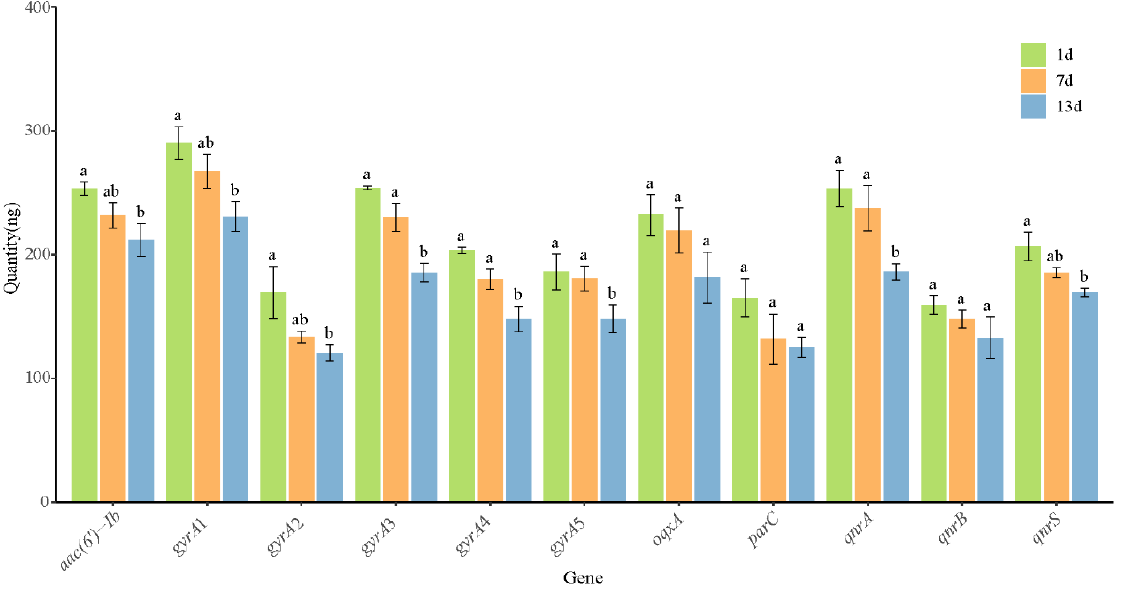
Figure 5. Short-term stability of the quantity of plasmid DNA reference materials stored at 37 ◦ C. For each gene, columns labeled with the same letter indicates that no significant difference was found in plasmid DNA quantity upon storage for different durations. Table 4. Ct values of qPCR for plasmid DNA reference materials stored at 37 °C (Mean ± SD). Gene